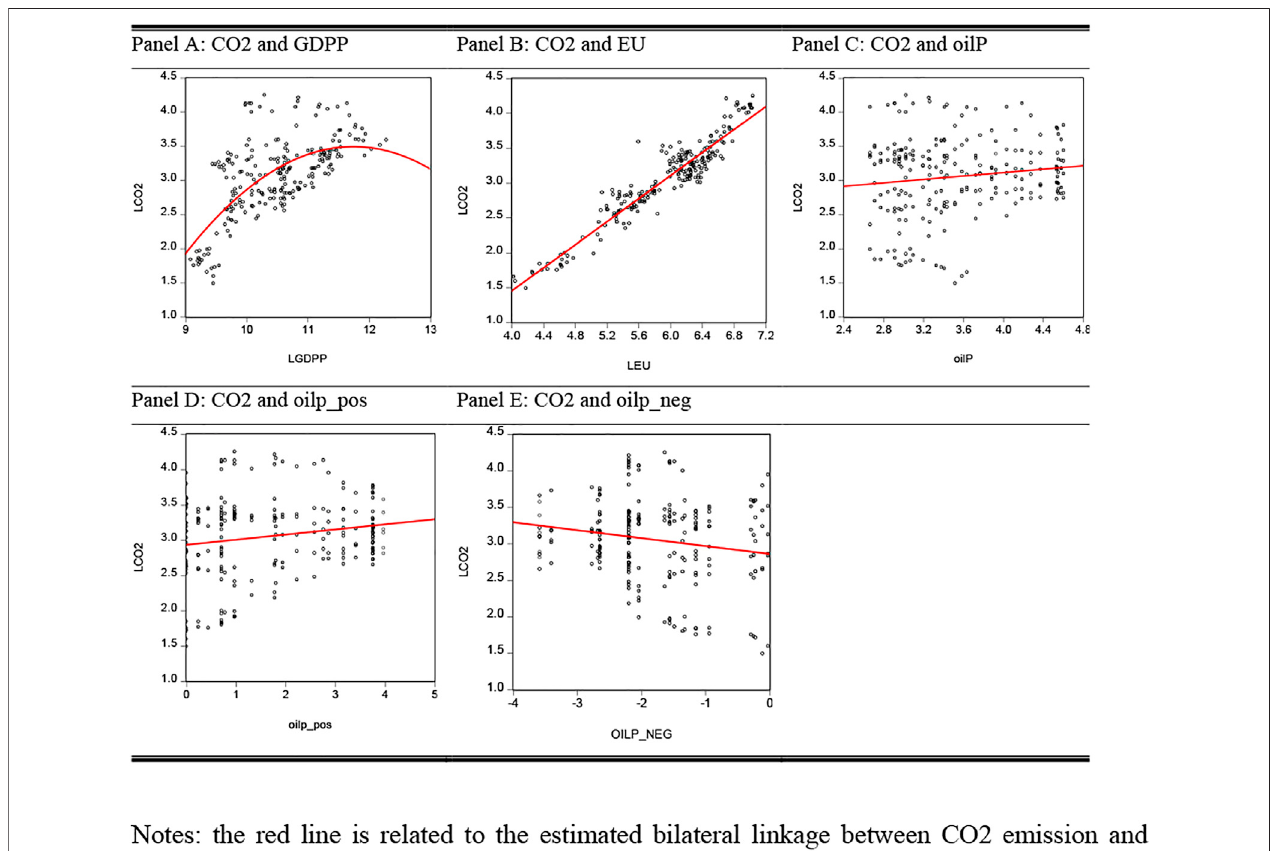
FIGURE 1 | bilateral correlation between explanatory variables and LCO 2